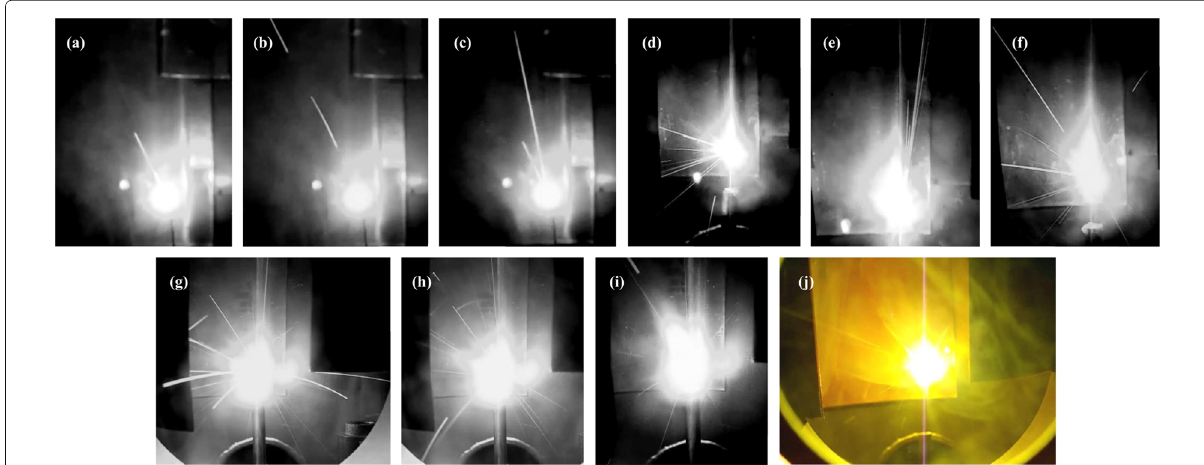
Fig. 16 Snapshots of jet-droplet ejection from the boiling sample. The video camera speed is 30 fm s − 1 , and its exposure time is 1/60 s. a , b & c : run #2 (65 W). The central bright ball is an effect of halation. The actual sample diameter is about one half of the ball. The field of view is ∼ 35 mm across. In this low laser power (65 W) experiment only the laser spot and its vicinity is above boiling temperature, and hence jet-droplets are ejected in ∼ 10 o’clock direction where laser beam comes from. a and b are successive video frames. In a , the first jet-droplet is ejected while the jet is still extending for a second droplet. In b , the first and second jet-droplets are seen. The length of their trajectories and the exposure time give their velocities, ∼ 0.6 m s − 1 . d , e & f : run #39-2, #39-1, and #38 (all 100 W), respectively. Thin trajectories tend to elongate longer, indicating that smaller droplets have higher ejection speeds. g , h & i : run #83 (200 W). Experiments with high laser power (200 W) produce jet droplets in all directions because the entire sample are kept above boiling temperature. In g , thick and bent trajectories of several jet-droplets indicate their large size. In h , thin, straight and elongated trajectories stand out, indicating smaller and faster droplets than in g . Rarely a number of droplets are ejected in a fan-like, synchronized fashion, suggesting them being film droplets from a single bubble burst, as shown in i . j : run #32 (200 W). In a late phase of evaporation as shown in j , a thick cloud of condensed, ultra-fine particles, a source of light-scattering, develops and circulates in convective